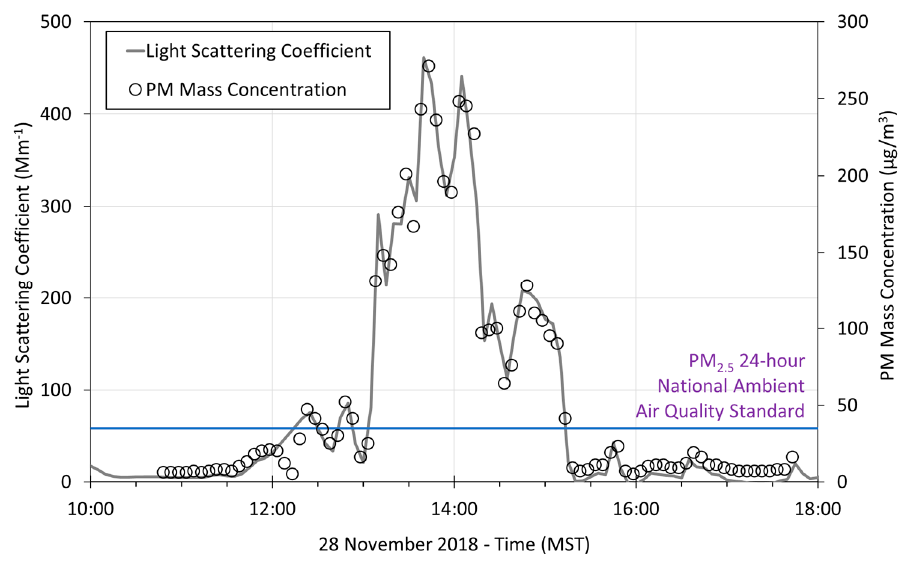
Figure 2. Time Series of ‘dry’ light scattering coefficient ( σ sp ) (520 nm) and ‘dry’ PM 2.5 mass concen- tration (µg/m 3 ).